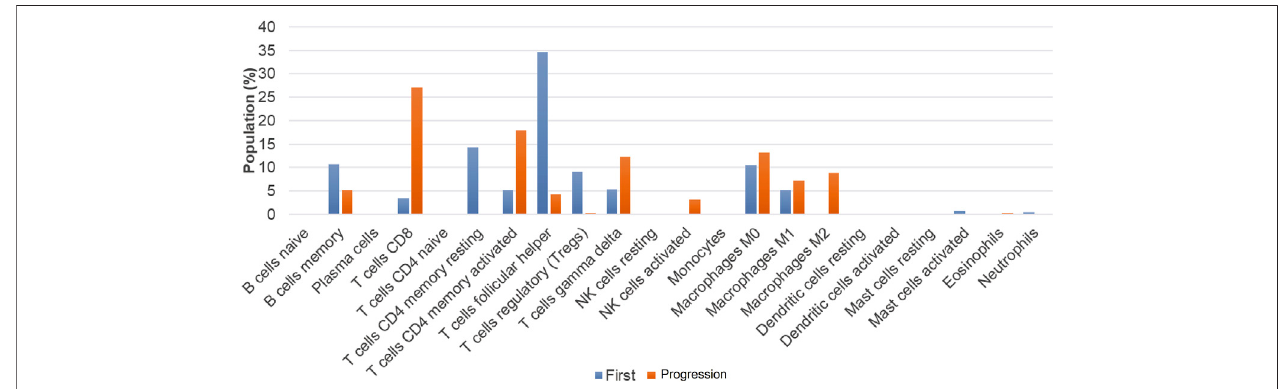
FIGURE 4 | Differences of 22 types of immune cells between the primary and progression